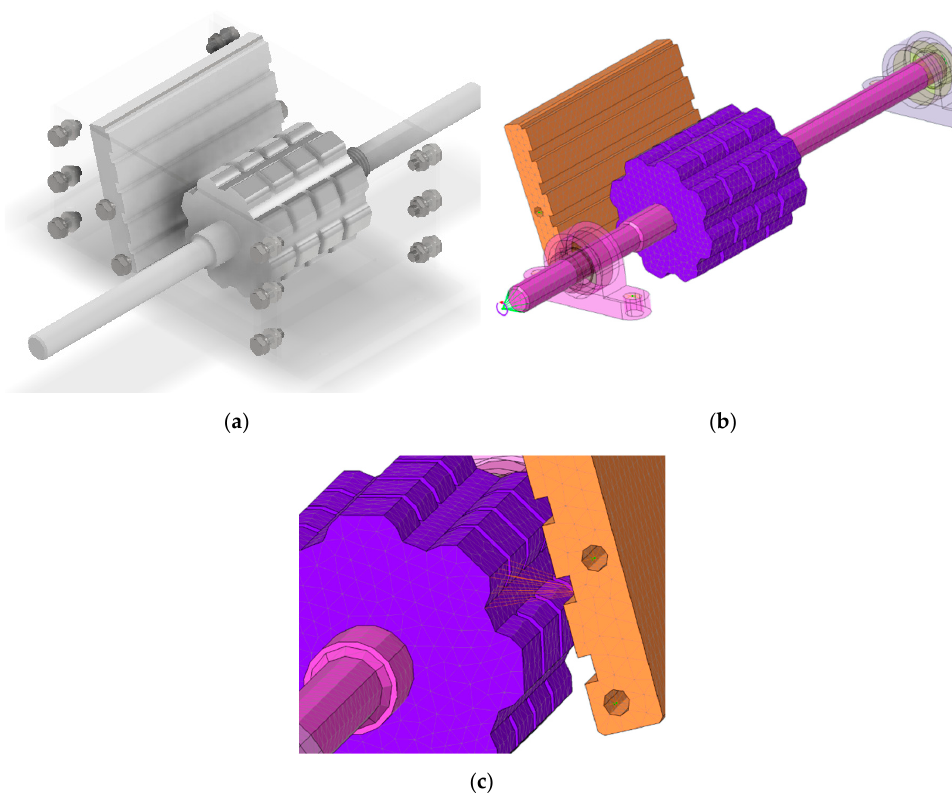
Figure 18. ( a ) Fracture mechanism for Metohuayo fruits; ( b ) mesh of fracture mechanism; ( c ) detailed mesh of the toothed wheel and toothed wall.